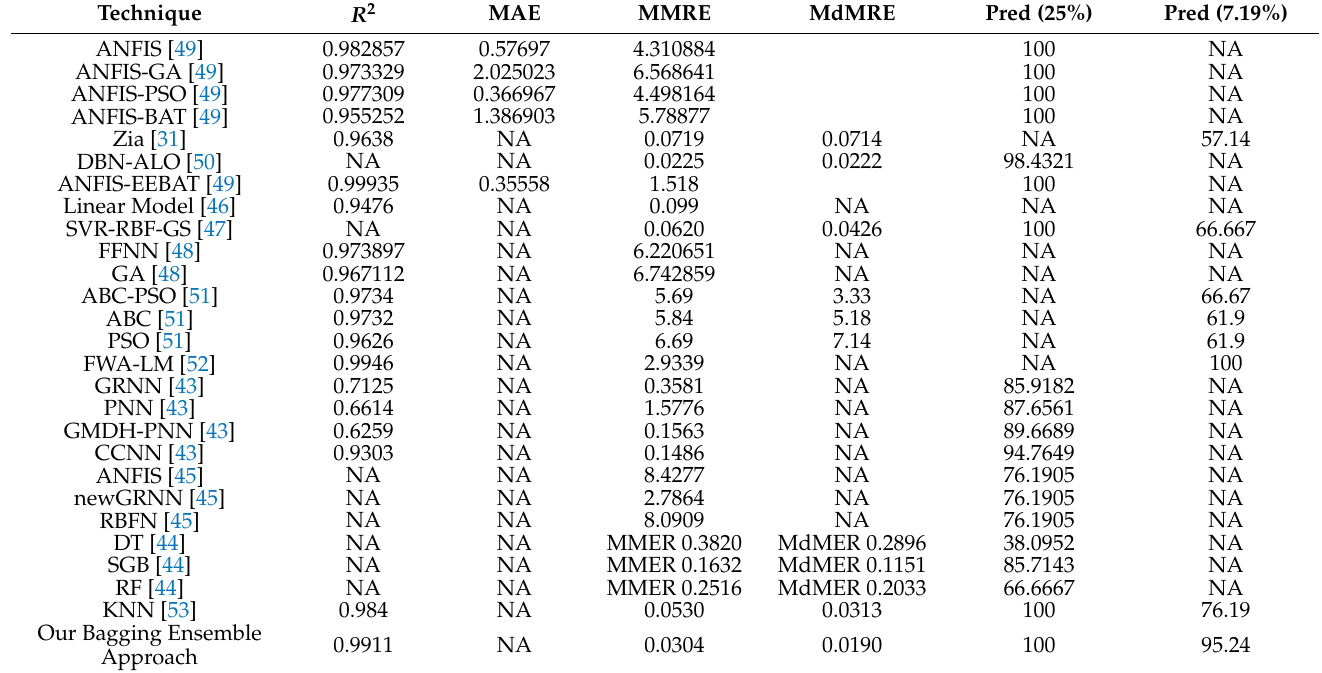
Table 16. Comparison of different techniques using the same